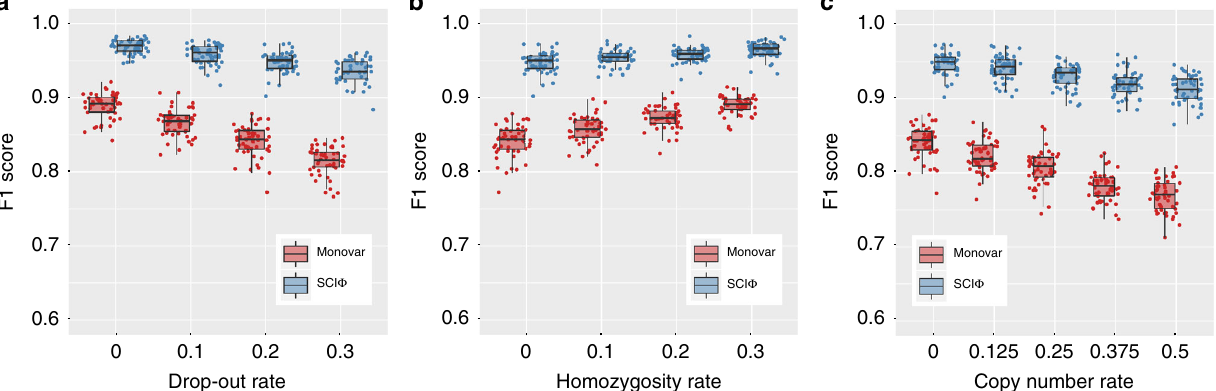
Fig. 3 Summary statistics of the F1 performance of SCI Φ and Monovar on simulated data. F1 performance depending on different levels of drop-out events ( a ), homozygosity ( b ), and copy number rates ( c